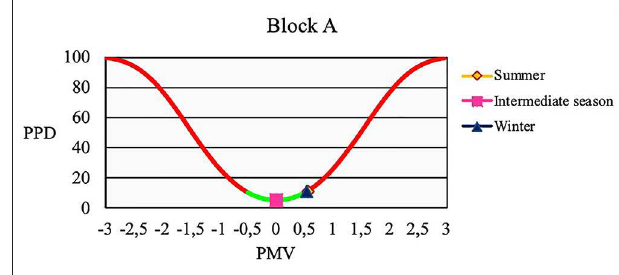
FIGURE 6 | PMV and PPD indices for Block